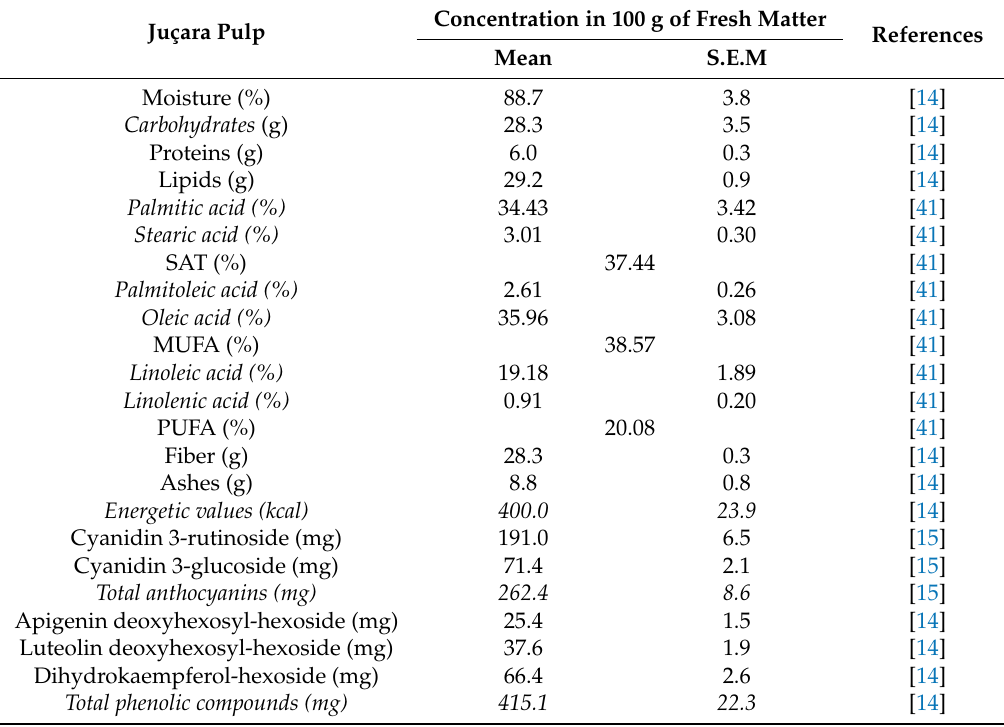
Table 3. Juçara pulp ( E. edulis Mart.)